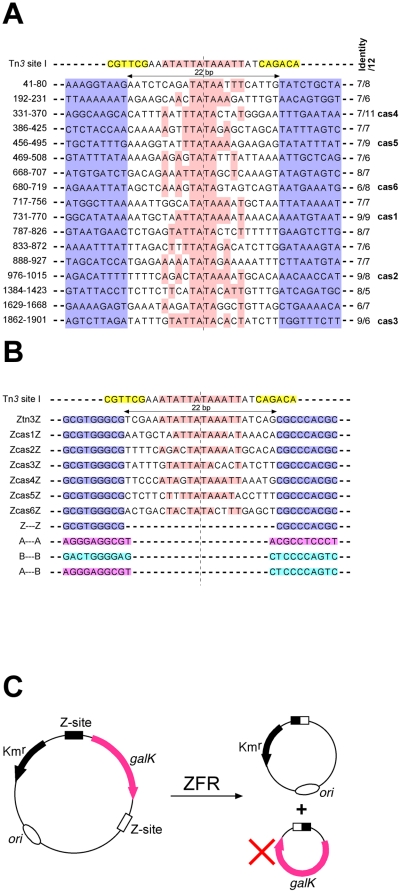
Casein gene sequences, Z-sites, and recombination assay.(A) Tn3 res site I (top line) and the seventeen TATA-containing sequences from the β-casein gene intron 1 (Genbank accession number X14711), aligned with the central TATA of site I. Sequences are numbered from the start of exon 1. The motifs in site I bound by the resolvase C-terminal domains are highlighted in yellow. Bases identical to site I within the central 12 bp of the casein sequences are highlighted in pink. The column on the right gives the number of bases identical to the central 12 bp of site I (the number before the slash is for the alignment shown, and the number after the slash is for the sequence aligned in the opposite orientation). The six ‘cas’ sequences, whose central 22 bp sequences were used in the recombination sites analysed in this study, are indicated. The 9 bp sequences flanking the central 22 bp are also shown (highlighted in blue); these sequences would be bound by the ZFR zinc finger domains if the genomic casein gene sequences were to be targeted as Z-sites (see Figure 1B). (B) Sequences of site I and Z-sites. The Z-site motifs recognized by the Zif268 domains are highlighted pale blue. The central 22 bp sequences of the ZcasZ sites are from the casein gene sequences shown in part A. Identities of the sequences to the central 12 bp of site I are highlighted pink. Note that the ZcasZ sequences are aligned here to maximize their matches with site I, so some are in the opposite orientation from part A. Motifs recognized by mutant Zif268 domains ZifA and ZifB are highlighted in magenta and cyan respectively. See text for further details. (C) Z-site substrate plasmids and colony colour assay. Recombination between the two Z-sites (boxes) deletes the galK gene, causing colonies to be pale rather than red on MacConkey-galactose indicator plates.